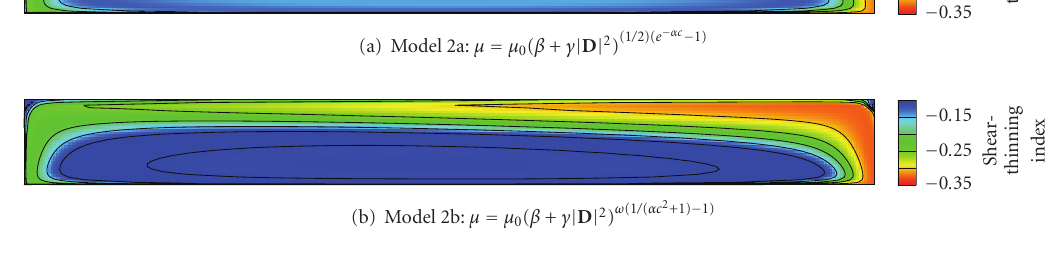
Figure 13: Shear-thinning